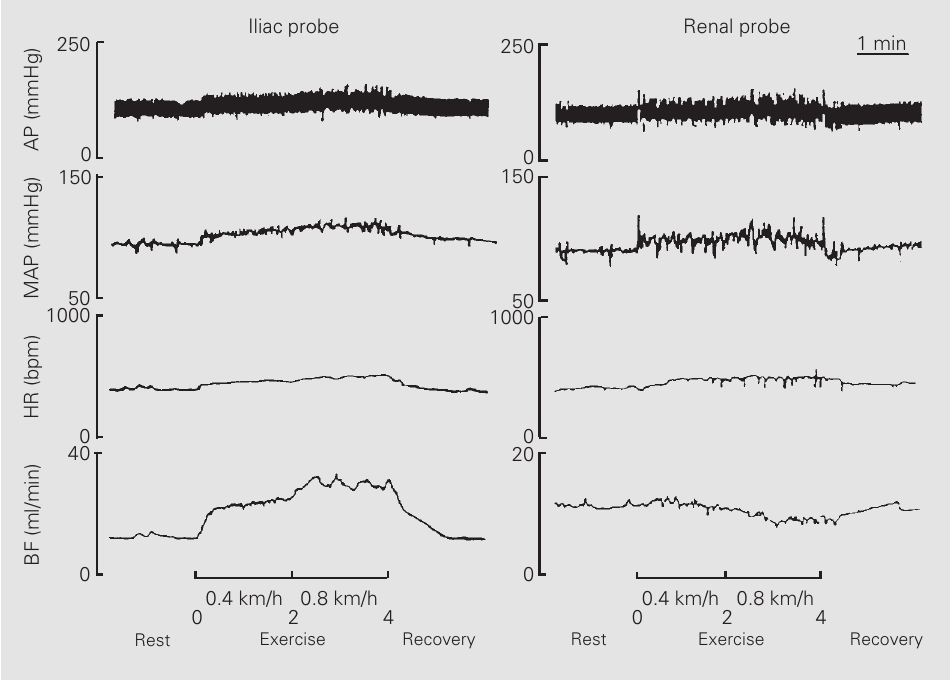
Figure 2 - Recordings of arterial pressure (pulsatile = AP and mean = MAP), heart rate (HR) and iliac (left panel) or renal (right panel) blood flow (BF) in 2 rats under resting conditions, during graded exercise (0.4 and 0.8 km/ h) and during recovery. Repro- duced from Ref. 5, with permis-